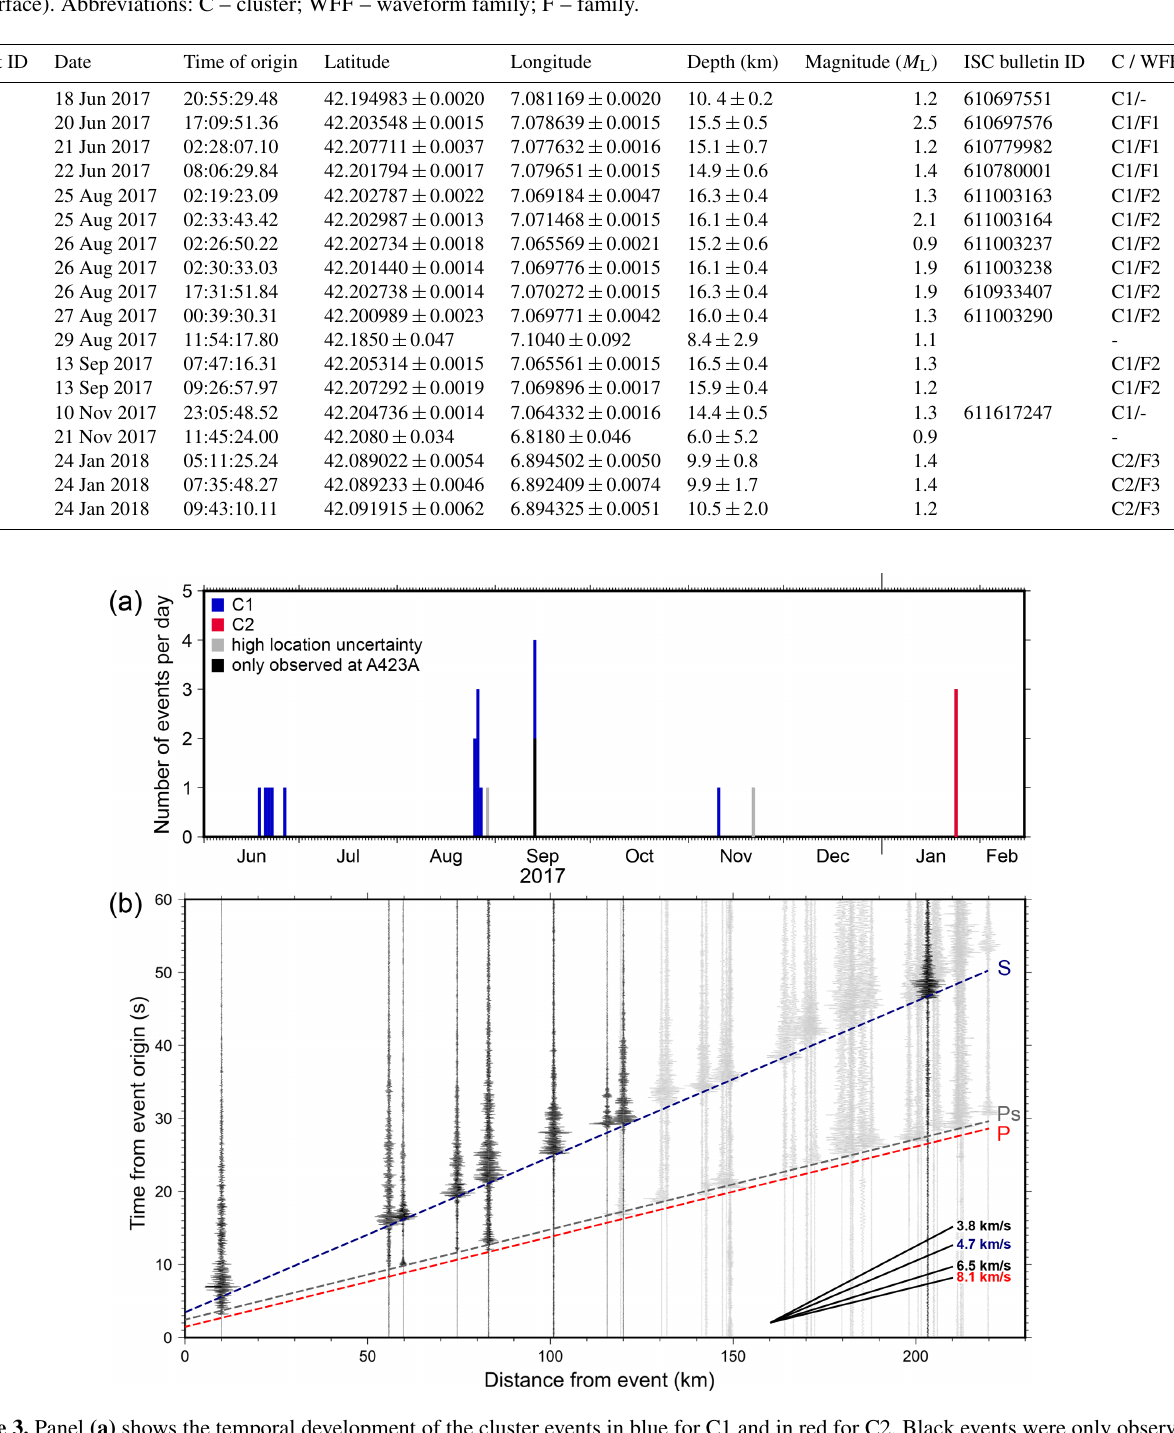
https://doi.org/10.5194/se-12-2553-2021 Solid Earth, 12, 2553–2571,